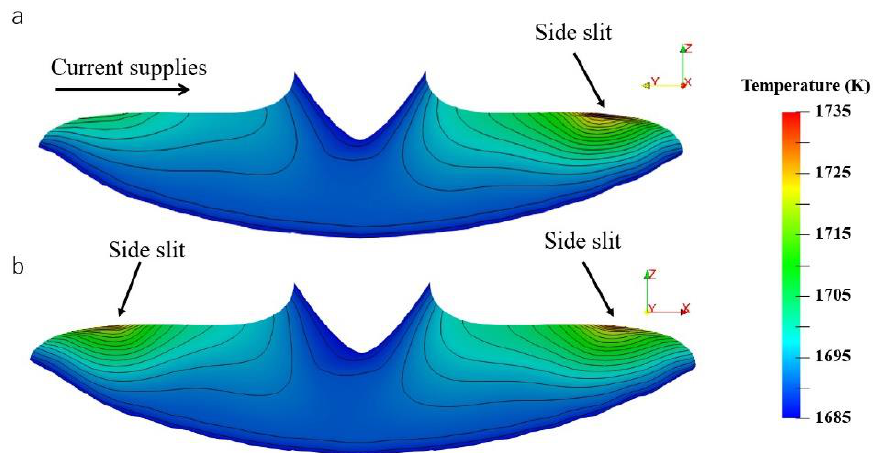
Figure 6. Temperature distribution in the melt: ( a ) cross section in the X plane (in the vicinity of current supplies); ( b ) cross section in the Y plane (perpendicular to the main slit).